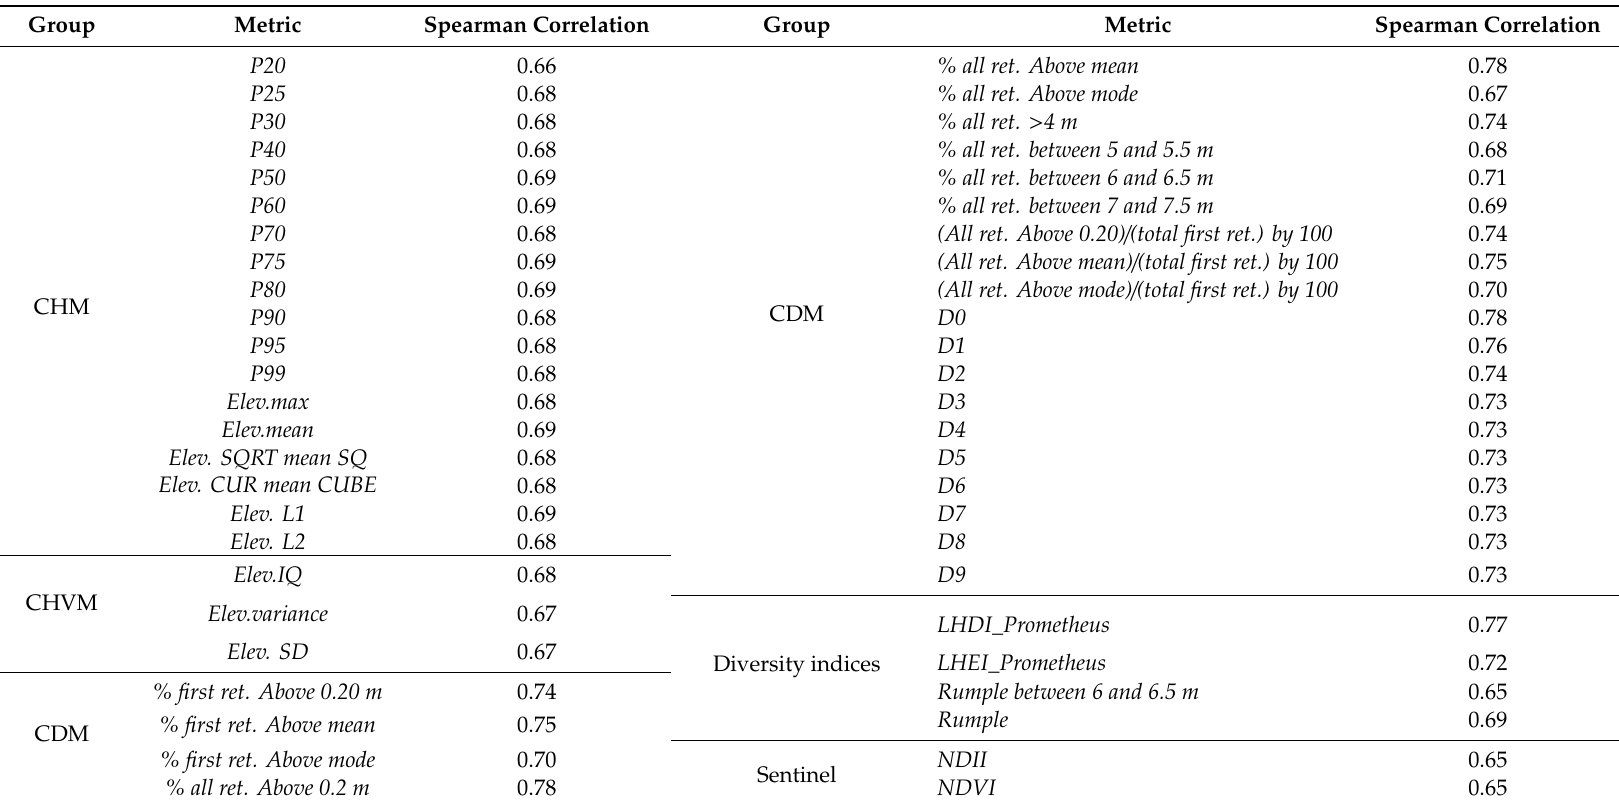
Table A2. ALS and Sentinel 2 metrics with highest Spearman’s rank correlation coe ffi cients (above 0.65).